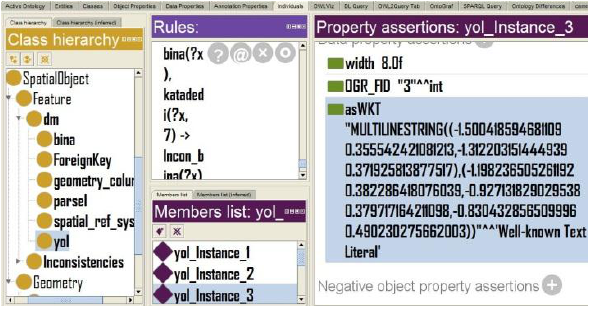
Figure. 4. Result of the second